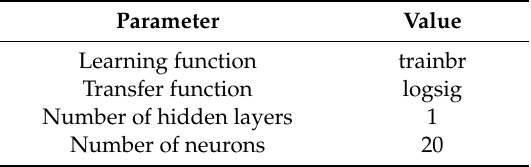
Table 2. Combination of the design parameters.